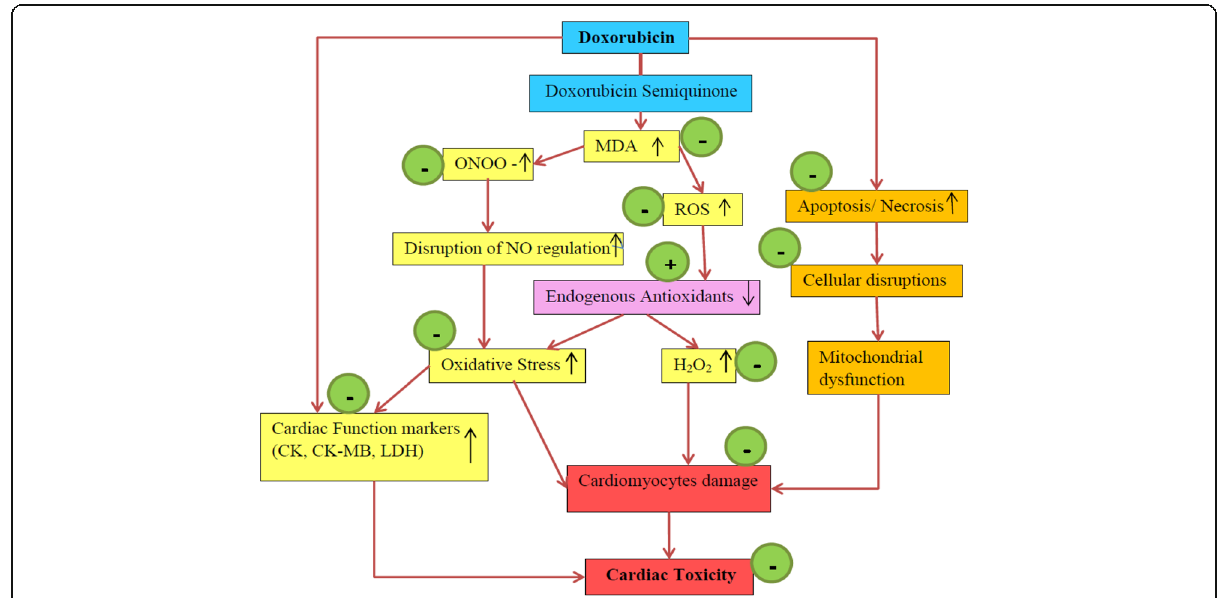
Fig. 3 Hypothetical pathway describing the possible underlying mechanism of DOX induced cardiotoxicity and protective effect of AHE. Green circles indicate points of AHE treatment effect, − sign indicates inhibition and + sign indicates